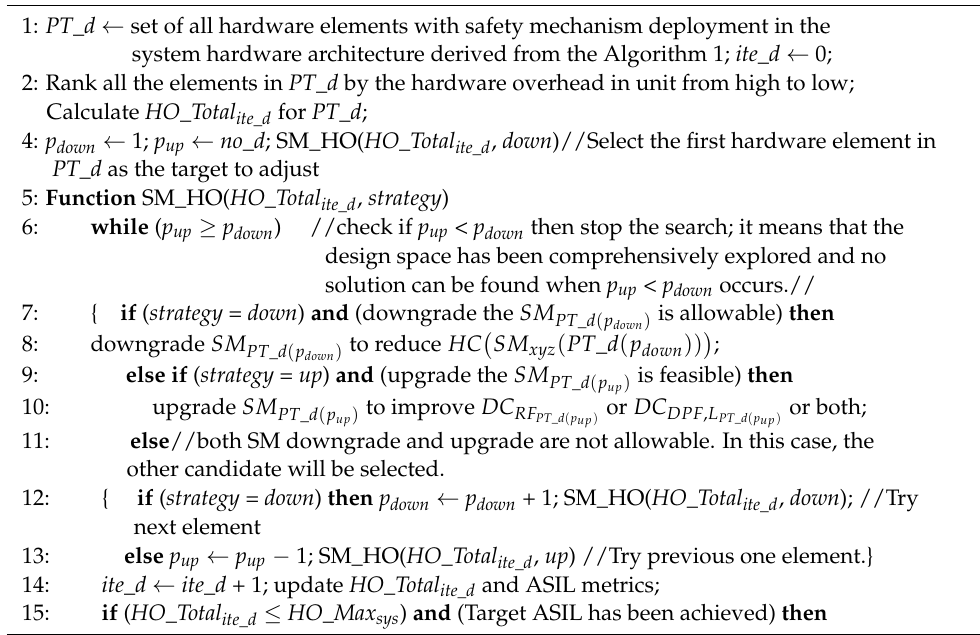
Algorithm 2: HO-oriented system hardware architecture